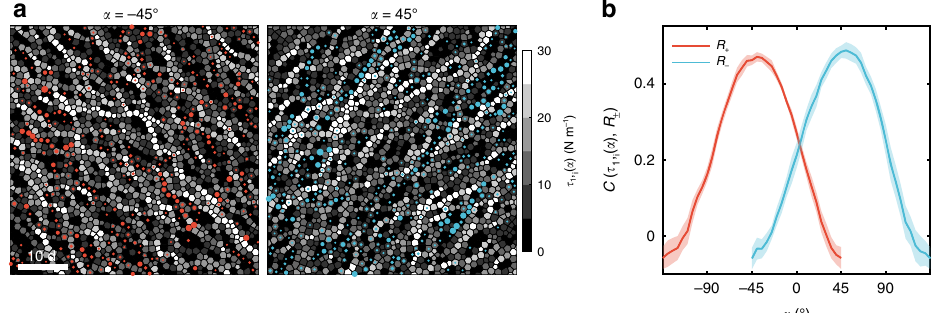
Fig. 2 Anti-correlation between particle rotations and polarized stress fi elds. a A superposition of the polarized stress fi elds τ 1 ( α ) with α = ±45° and the counterclockwise(red circles)/clockwise(blue circles) particle rotations, the same as in Fig. 1g. In background, the Voronoi cells of disks are painted according to the gray scales of τ 1, i ( α ) of each disk i . Scale bar = 10d. b The correlations C ( τ 1, i ( α ), R ± ) between particle rotations ( R + : counterclockwise, R − : clockwise) and τ 1, i ( α ) versus angle α . The bands indicate standard errors of six independent Correlation between structure and dynamics . Remarkably, we and the index j runs over all disks j in contact with disk i . In an found strong correlations between the micro-bands and the arbitrary Cartesian axes ð x 0 ; y 0 Þ , of an angle α with respect to the laboratory axes ( x , y ), the stress tensor is given by, spatial distributions of normal stress along ±45°, as shown in Fig. 2a. We denote the normal stress along α direction as the which we call pseudo stress-chains. We denote the fi eld of τ 1, i ( α )